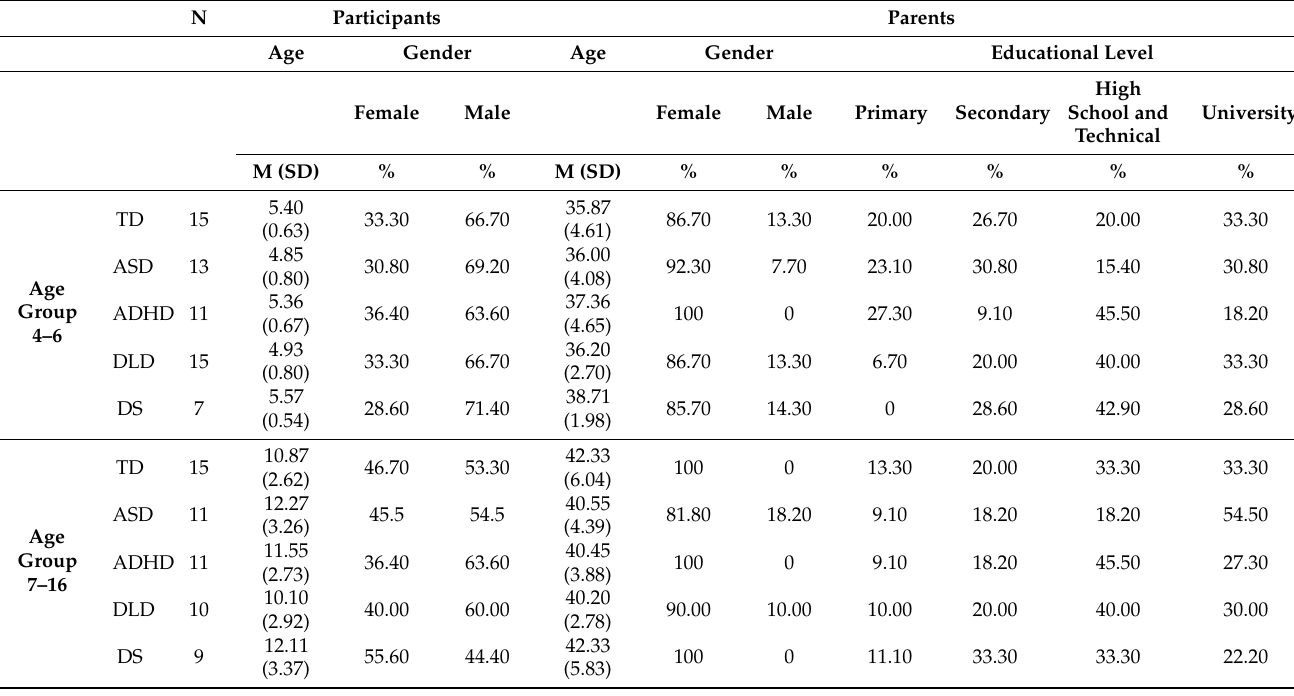
Table 1. Sociodemographic characteristics of the children and their